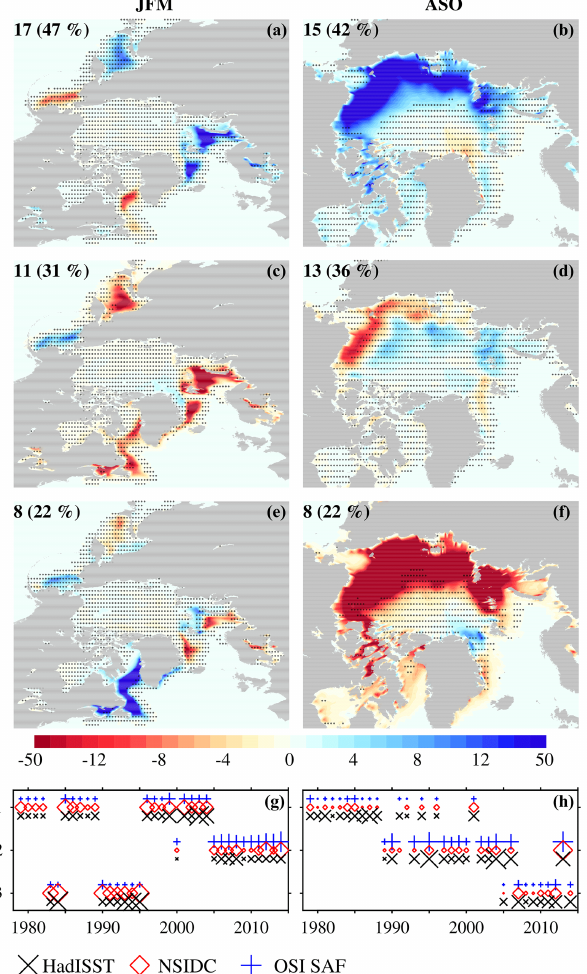
Figure 5. (a–f) Cluster patterns of Arctic SIC anomalies (shading; in JFM: a , c , e ; and ASO: b , d , f ). Stippling masks statistically non- significant anomalies at the 5% level; p -values at each grid point are computed through a t test that accounts for serial autocorrela- tion (Manubens et al., 2018). Each cluster’s percentage occurrence and the associated number of years whose anomaly pattern explains over the period 1979–2014 is indicated in each case. The shading color scale is adapted for a better view of the anomalies in the range ± 15. The area is zoomed in ASO (b, d, f) for a better view of the central Arctic. (g, h) Time series of cluster occurrence in HadISST (black crosses), NSIDC (red diamonds), and OSISAF (blue pluses). The larger the symbol size, the larger the Euclidean distance (root- mean-square difference) between a pattern of anomalies and the as- sociated cluster in a particular year (the maximum symbol size is shown in the legend). Clusters are calculated from the full SIC field without detrending (in contrast to detrended data shown in Fig.